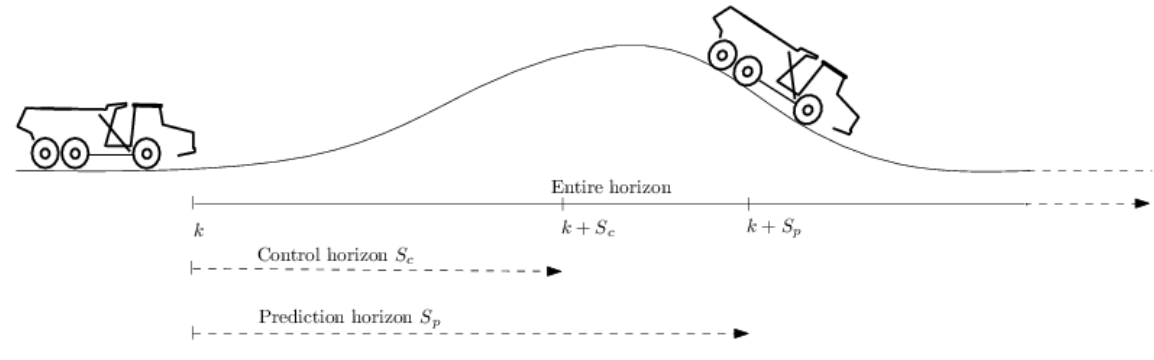
Figure 3. Illustration of the model predictive